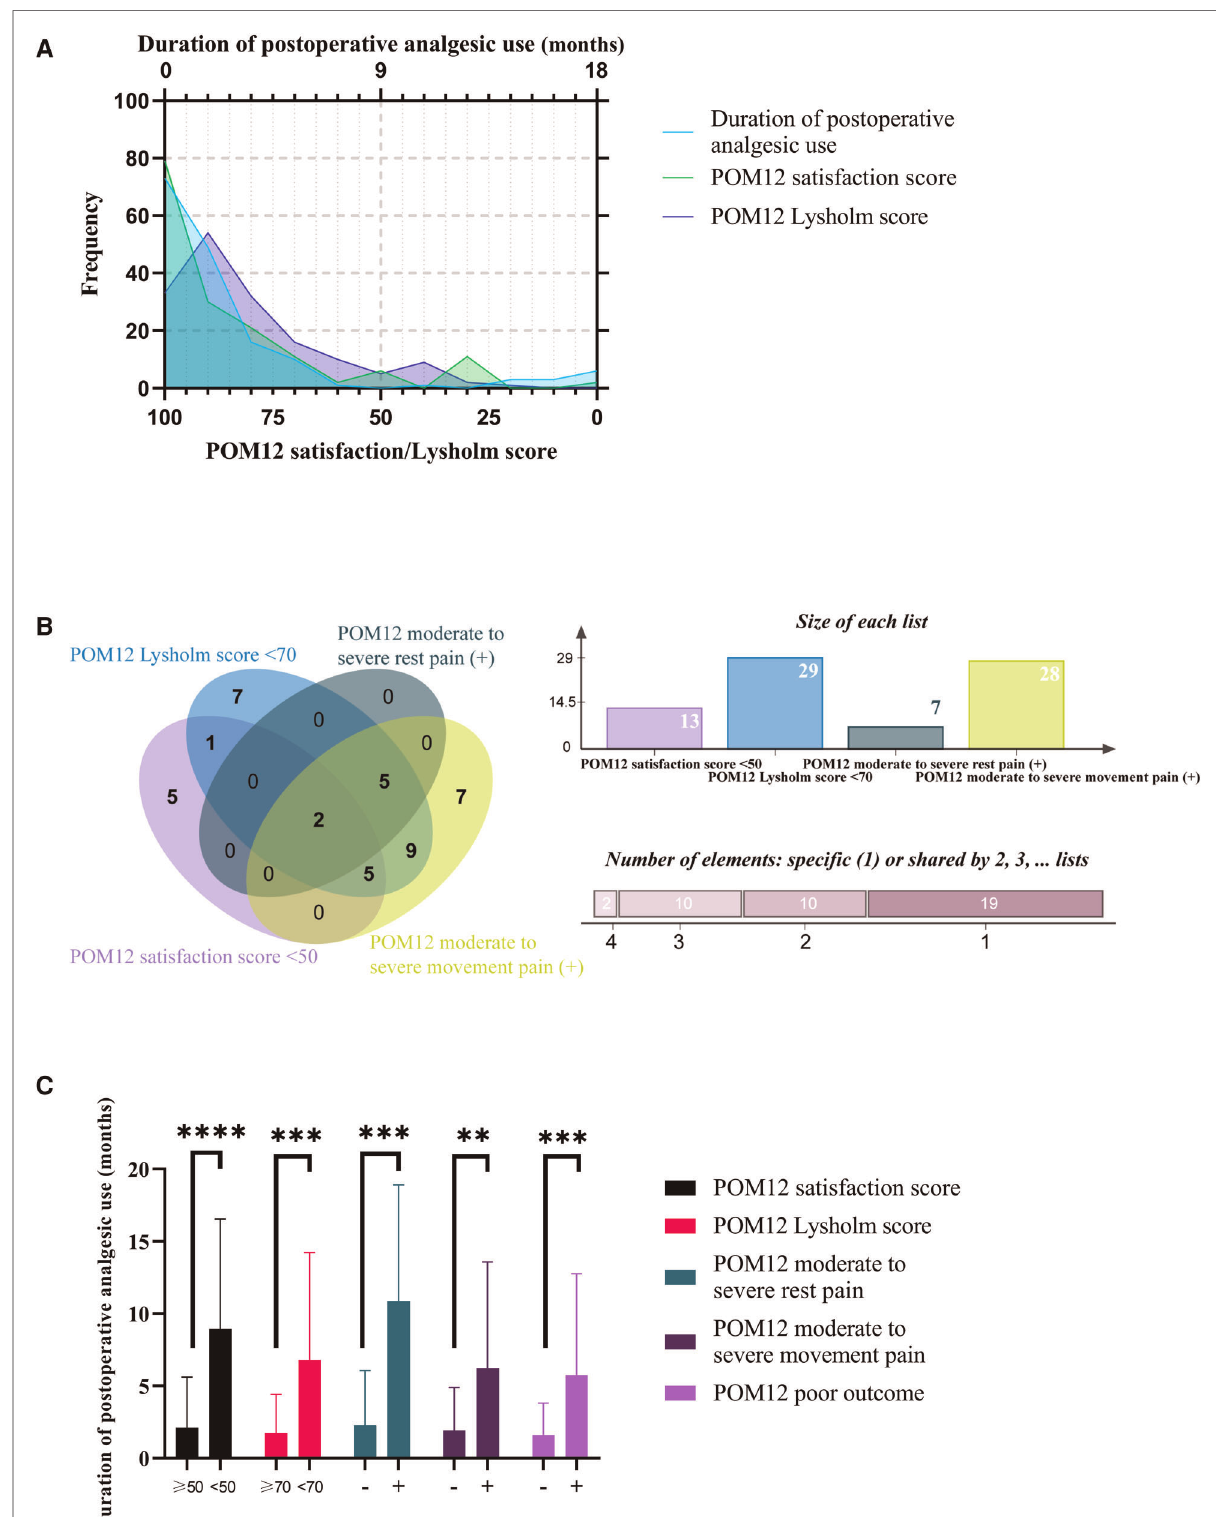
FIGURE 2 Descriptive statistical analysis of DAU. ( A ) Frequency distribution of DAU, POM12 satisfaction score, and POM12 Lysholm score. ( B ) Venn diagram of four subgroups of POM12 poor outcome. ( C ) DAU of cases with or without adverse outcomes. ***, p <0.001; ****, p